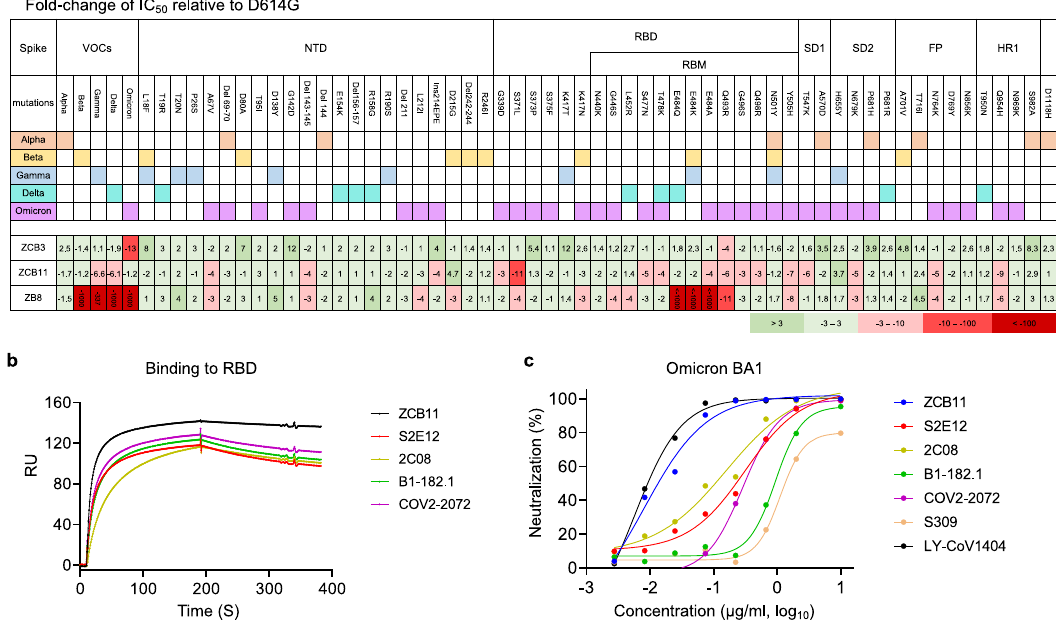
Fig. 3 ZCB11 resistance to natural mutations in SARS-CoV-2 VOCs and comparison with four public antibodies derived from IGHV1-58 family. a Fold change of IC 50 values relative to WT was determined by pseudoviruses carrying individual mutations or deletion against ZCB3 and ZCB11 as compared with ZB8. b Binding kinetics of ZCB11 to SARS-CoV-2 RBD was determined by SPR as compared with four public antibodies derived from IGHV1-58 family. The color coding indicates each individual antibody. c Neutralization of pseudotyped Omicron BA.1 by ZCB11 and four public antibodies as compared with two therapeutic antibodies (S309 and LY-CoV1404). The experiments were performed in duplicates. Source data are provided as a Source Data fi le. VOC variant of concern, IC 50 half inhibitory concentration, WT wildtype, RBD receptor-binding domain, SPR surface plasmon